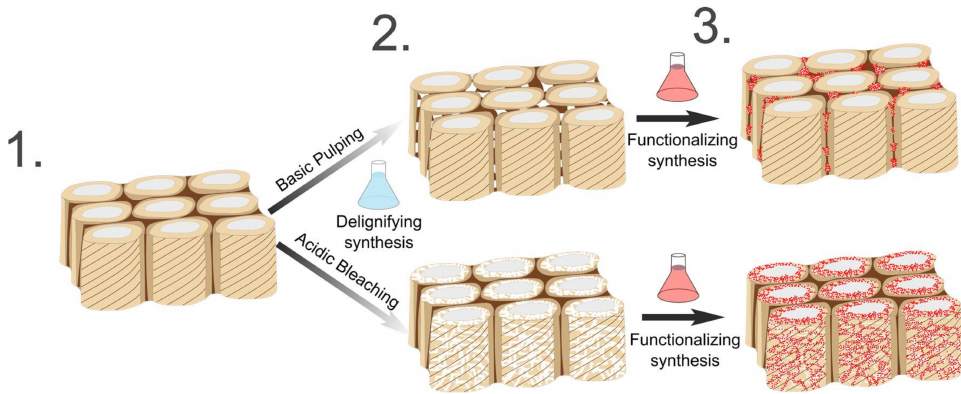
Figure 5. Preparation of wood-based hierarchical cellulose scaffolds for multi-functional applications. Native wood of variable dimensions ( 1 ) is immersed in the delignification bath to enhance porosity and cell wall accessibility on the cell wall level. The obtained wood-based cellulose scaffolds ( 2 ) can be functionalized via the integration of additional material into the induced porosity on the cell wall level. A preferential placement of the functional phase ( 3 ) can be guided in accordance to the anatomical response of the delignification